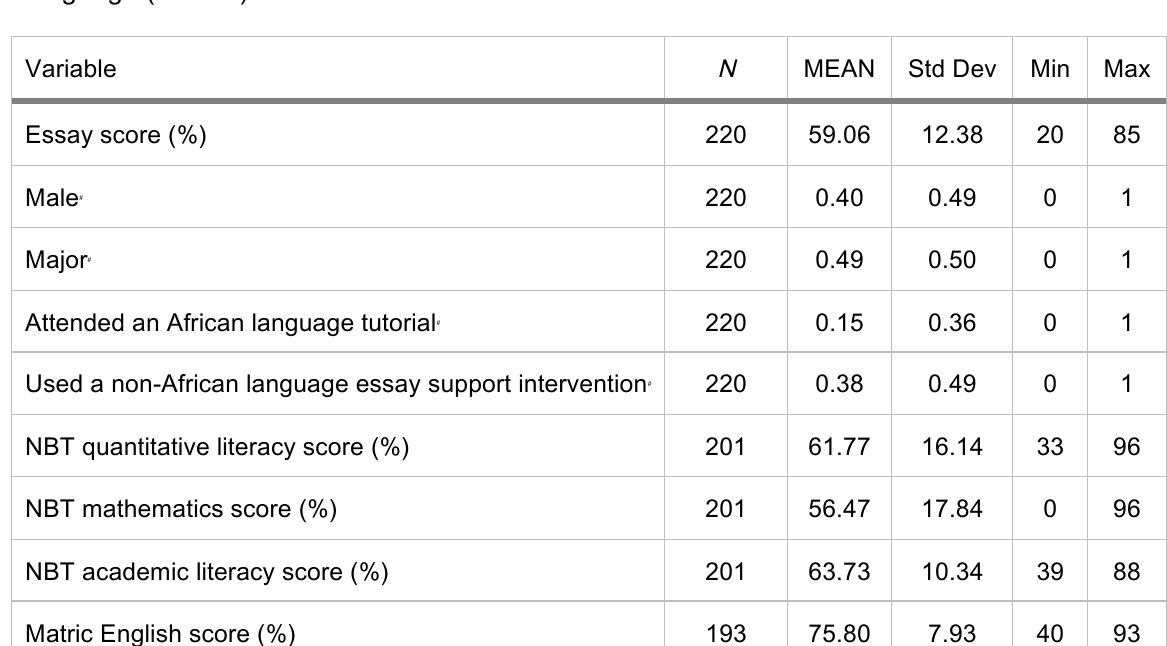
Table 1: Summary statistics for students who identify an African language as their first language ( n =